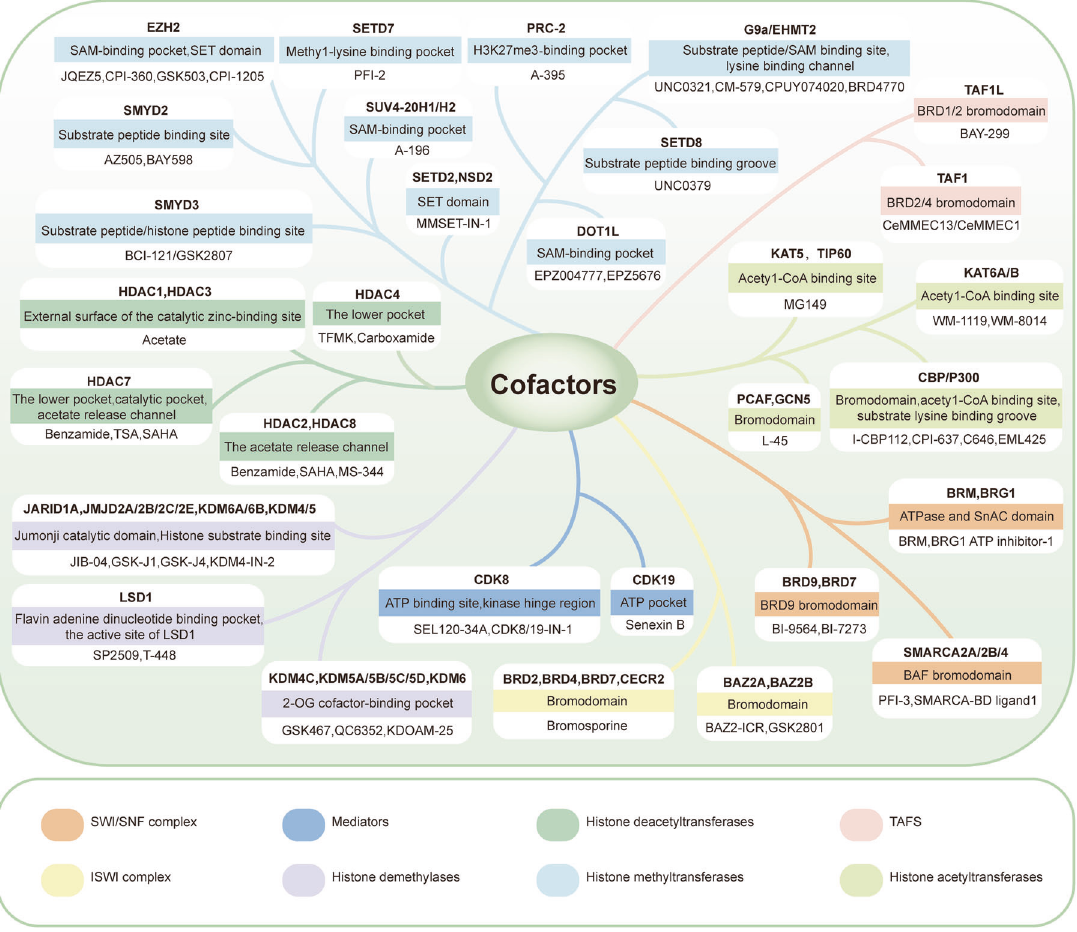
Fig. 6 The targeted domains/sites used to design cofactor inhibitors. Abnormal epigenetic changes are amenable to pharmacological intervention. The emergence of cofactors as oncology targets has spurred signi fi cant drug discovery efforts with the goal of identifying small- molecule inhibitors that target their enzymatic sites, binding pockets, and protein/TF interactions for therapeutic applications. Binding sites and representative drugs for each kind of cofactor are shown Signal Transduction and Targeted Therapy (2021)